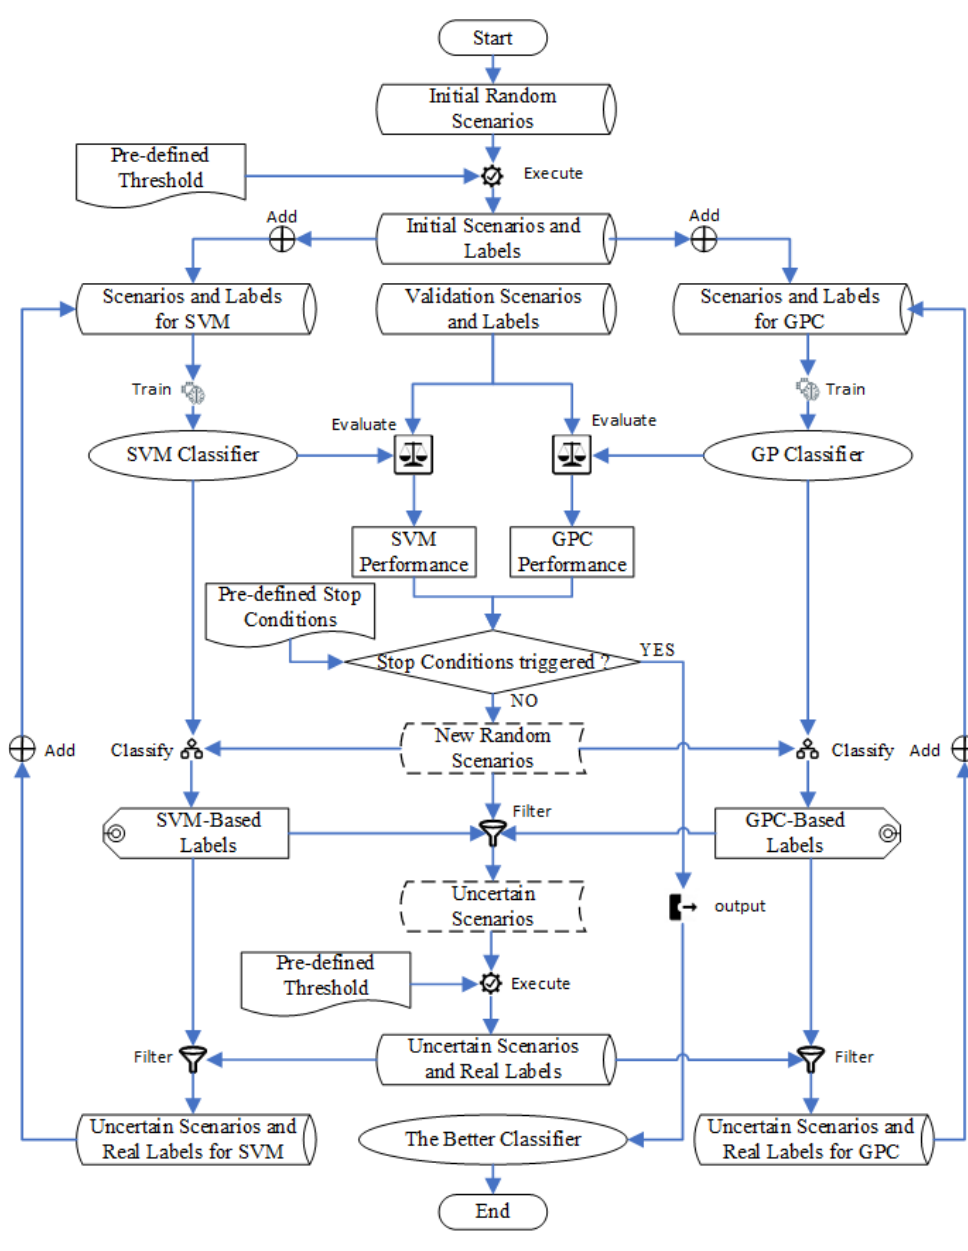
Figure 4. Flow chart of training GSVM and GGPC for scenario classi fi cation.